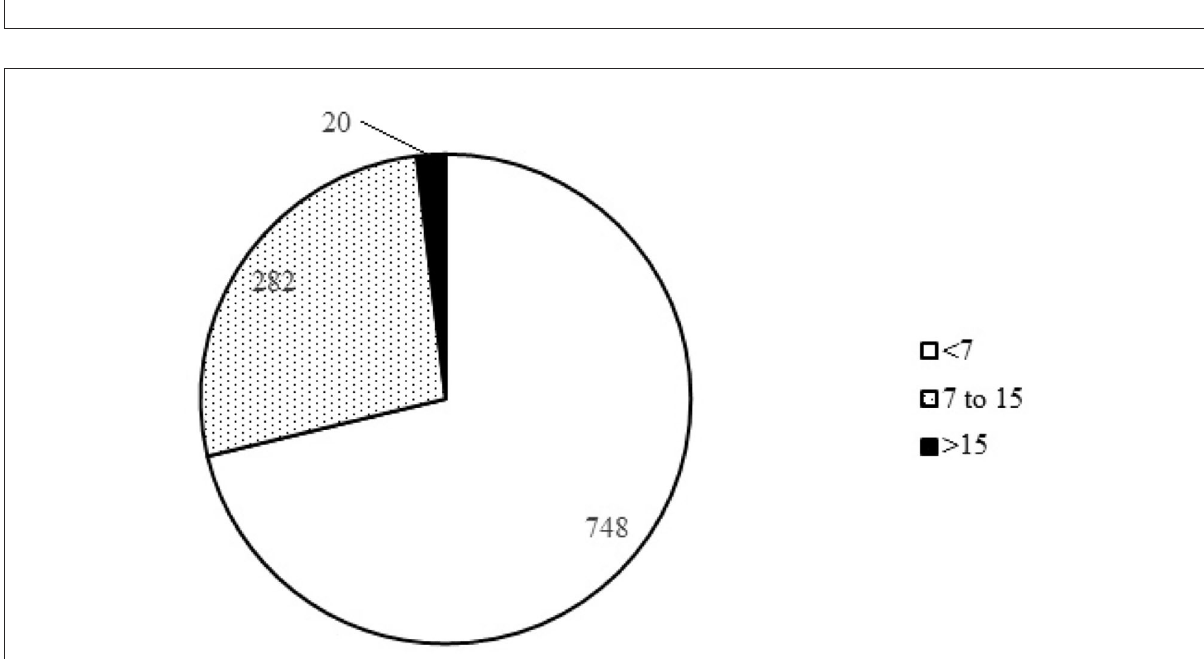
FIGURE3 Form of the ideological and political content of